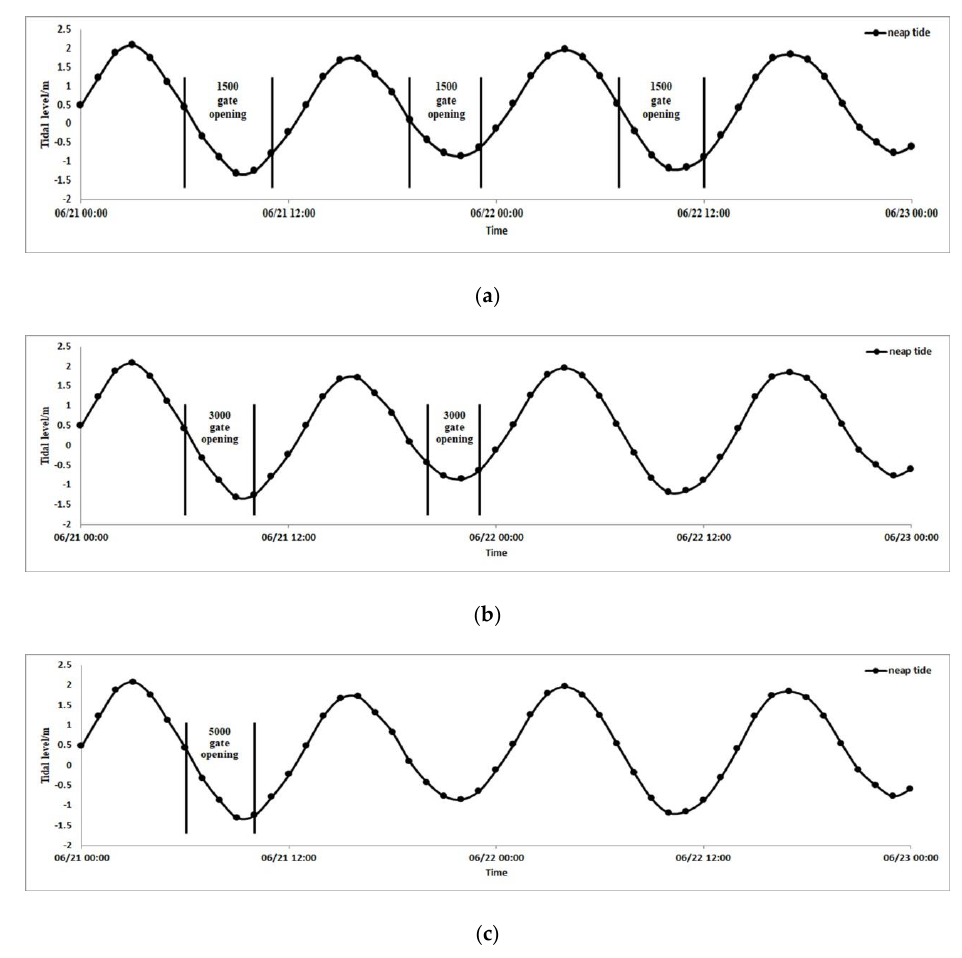
Figure 7. The dispatch diagram of gate control boundary discharging with flow of ( a ) 1500 m 3 / s, ( b ) 3000 m 3 / s and ( c ) 5000 m 3 / s, respectively during spring tide.